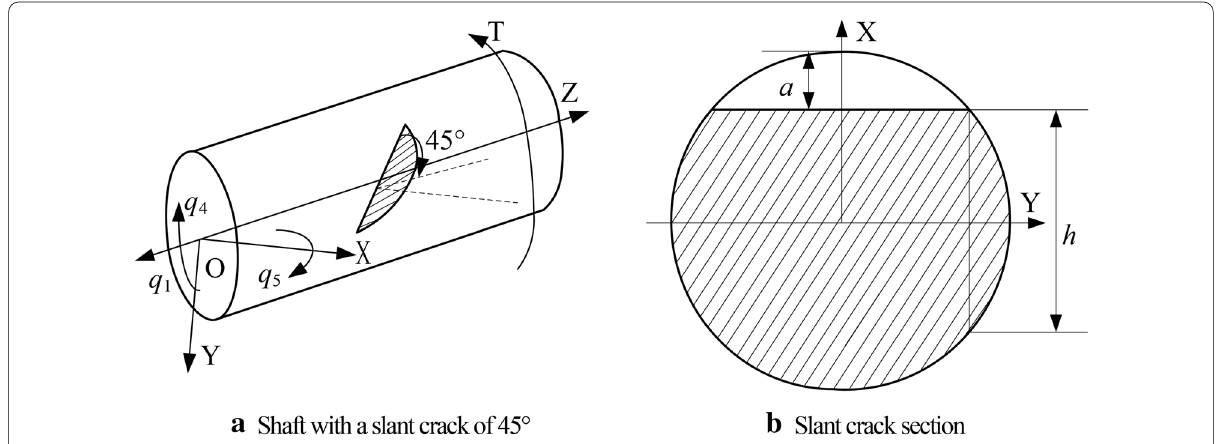
Figure 2 Diagrammatic sketch of the shaft with a slant crack and the slant crack